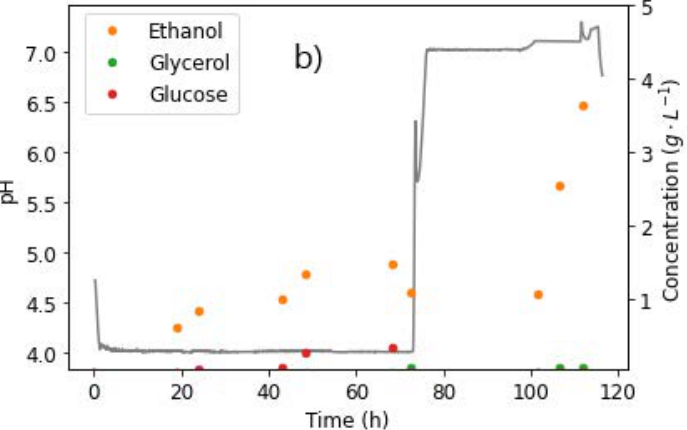
Figure 9. pH steps and extracellular concentrations of ( a ) fumarate, malate, and ( b ) side prod- ucts, taken from the reactor during fermentation with R. delemar at constant glucose feed rate of 0.329gL − 1 h − 1 . After 72 h, the glucose feed was switched to zero, pH increased to 7, and nitrogen feed decreased to 0.0625mgL − 1 h − 1 . Anaerobic conditions were also induced in this phase.